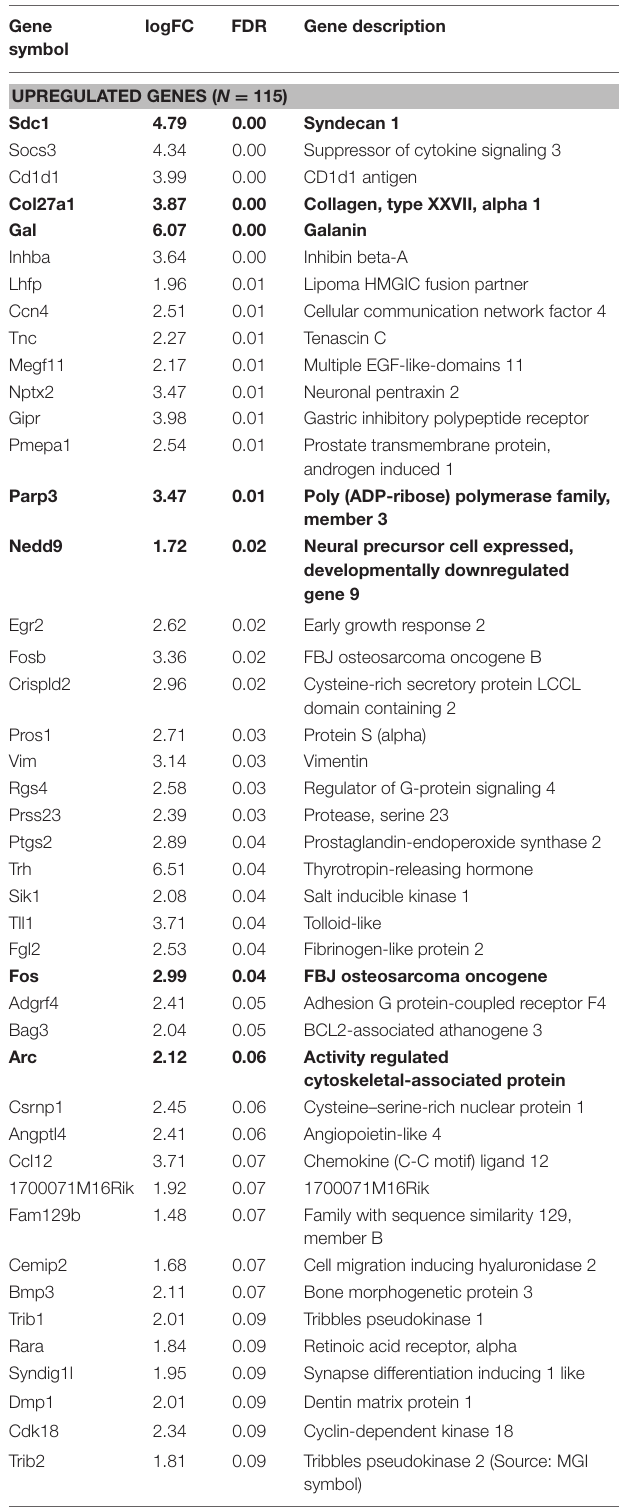
TABLE 1 | Differentially expressed genes in neurons in the contralateral hippocampus (CLH) at 24h after kainate-induced status